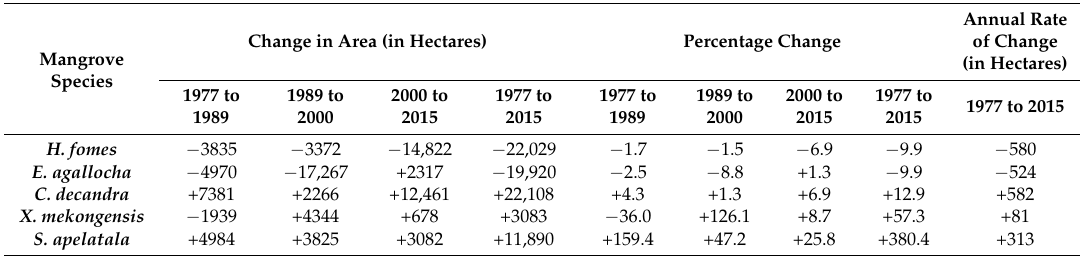
Change in Area (in Hectares)